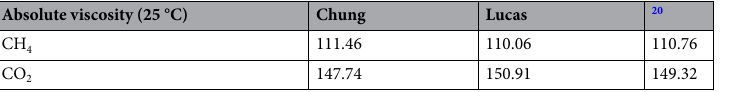
Table 3. Calculated viscosity values for pure methane and pure carbon dioxide according to Chung, Lucas, compared to the viscosity from 20 .